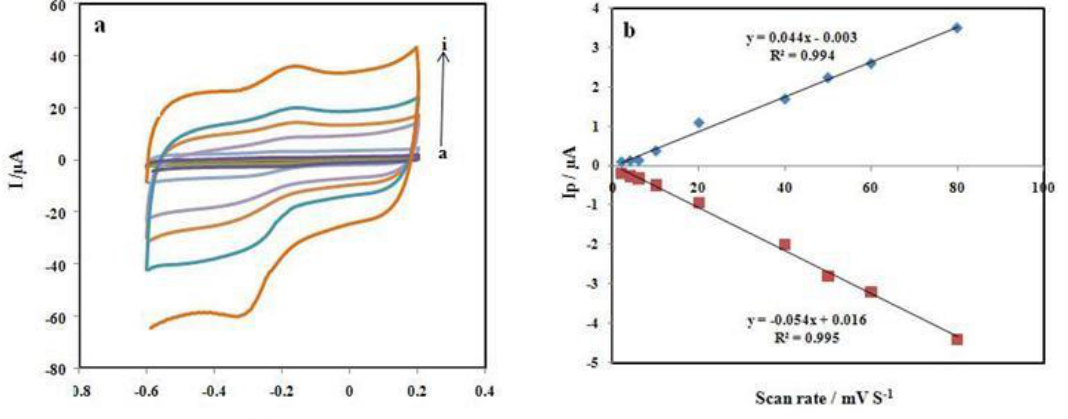
Fig. 3. (a) Cyclic voltammograms of Cyt c at differentscan rates: 2, 4, 6, 10, 20, 40, 50, 60 and 80 mV/s from a to i. (b) Relationship